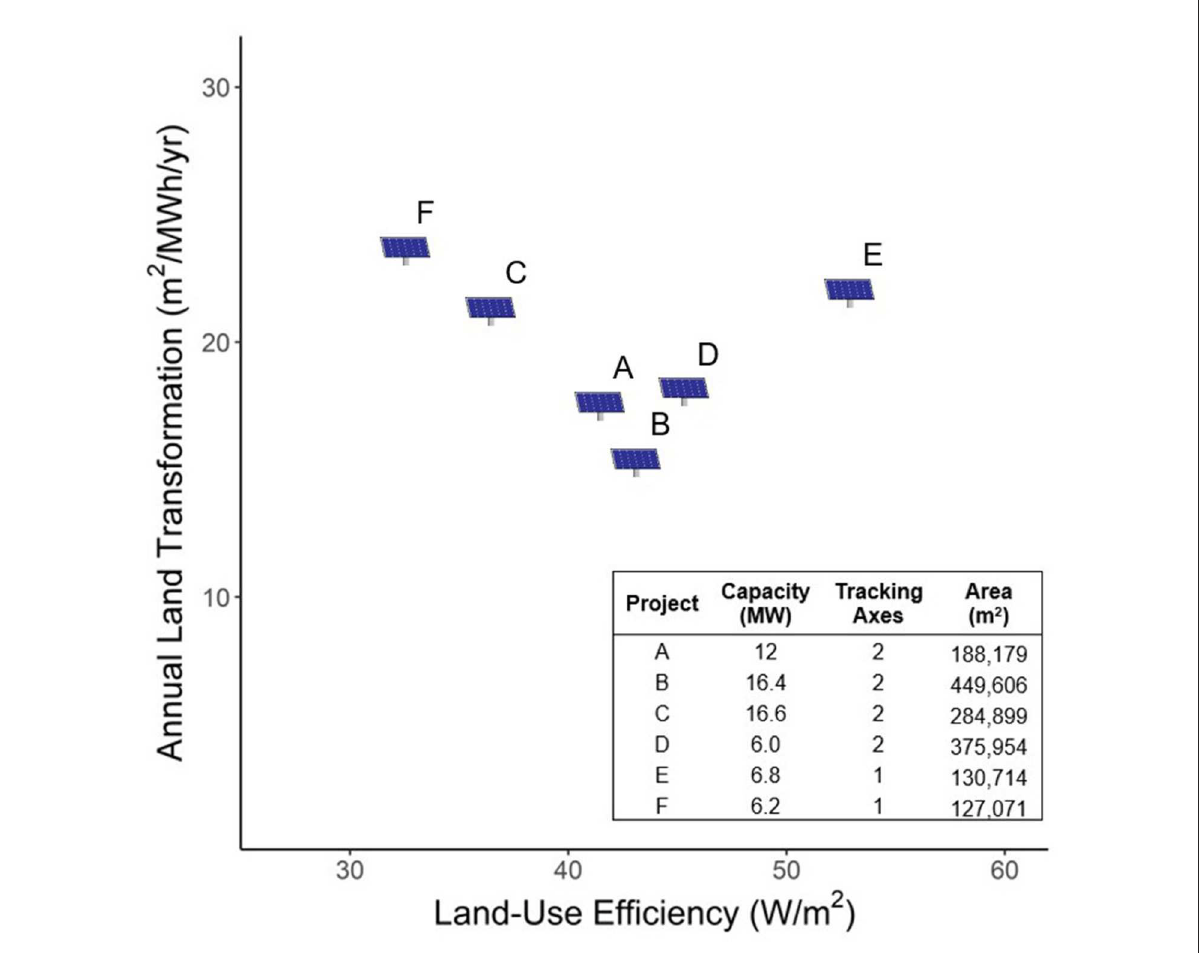
FIGURE6 The land-use efficiency and land transformation of six randomly-chosen, operational large-scale solar PV installations within the state of California, United States. Additional site information and installation details can be found in Appendix C.